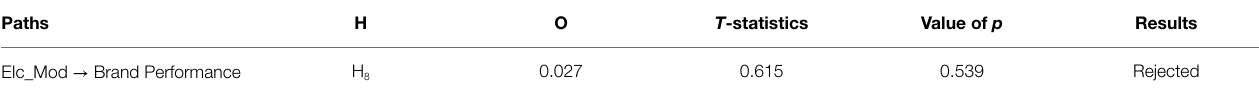
TABLE 7 | Moderating